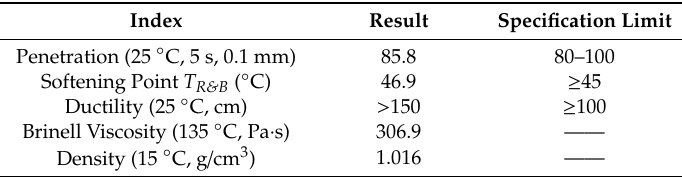
Table 1. Basic properties of neat